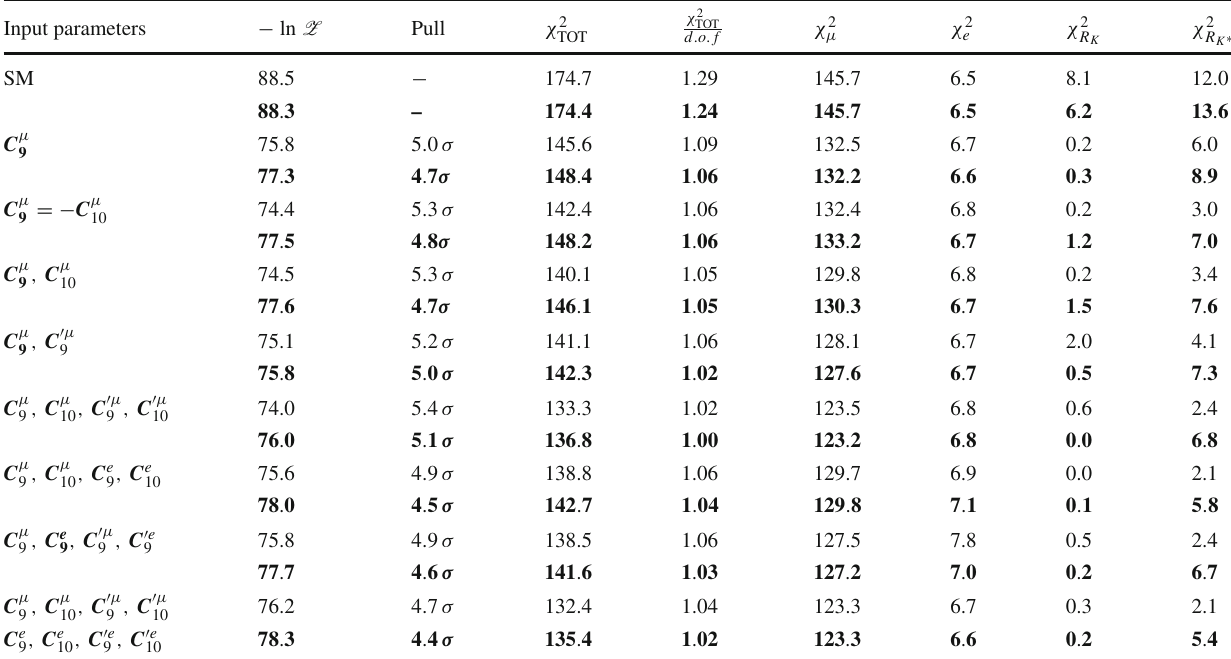
Table 3 Bayesian evidence, pull from the SM, and chi-squared statistics for the best-fit points of the considered scenarios. Bold highlighted rows correspond to the new data, while the unbolded ones show the previous determinations Input